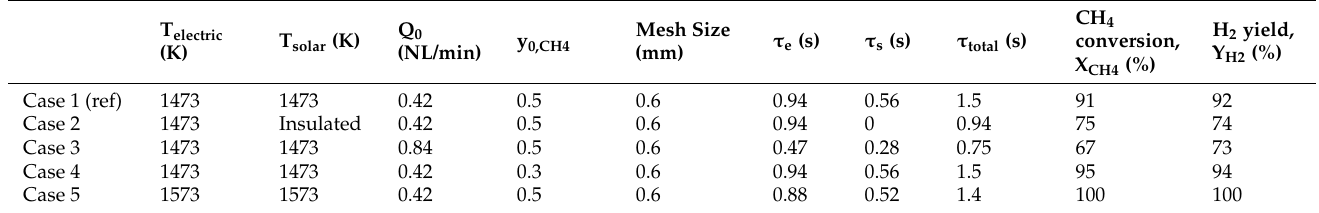
Table 2. Results of parameter effects on performance metrics of gas-phase methane pyrolysis.